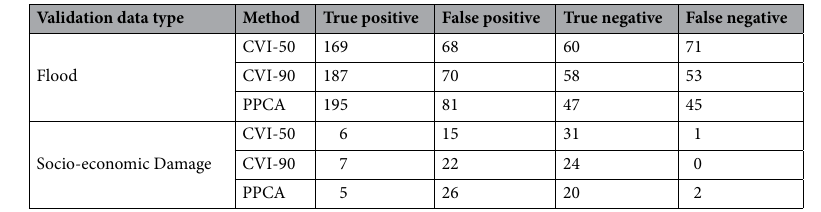
Table 7. CVI validation with flood and socio-economic